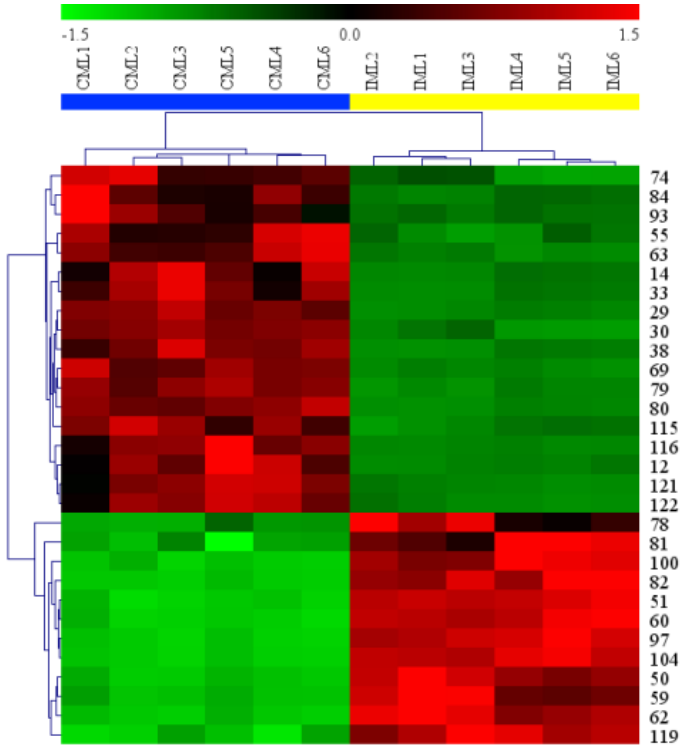
Figure 6. Heatmap visualizing the intensities of potential chemical markers.